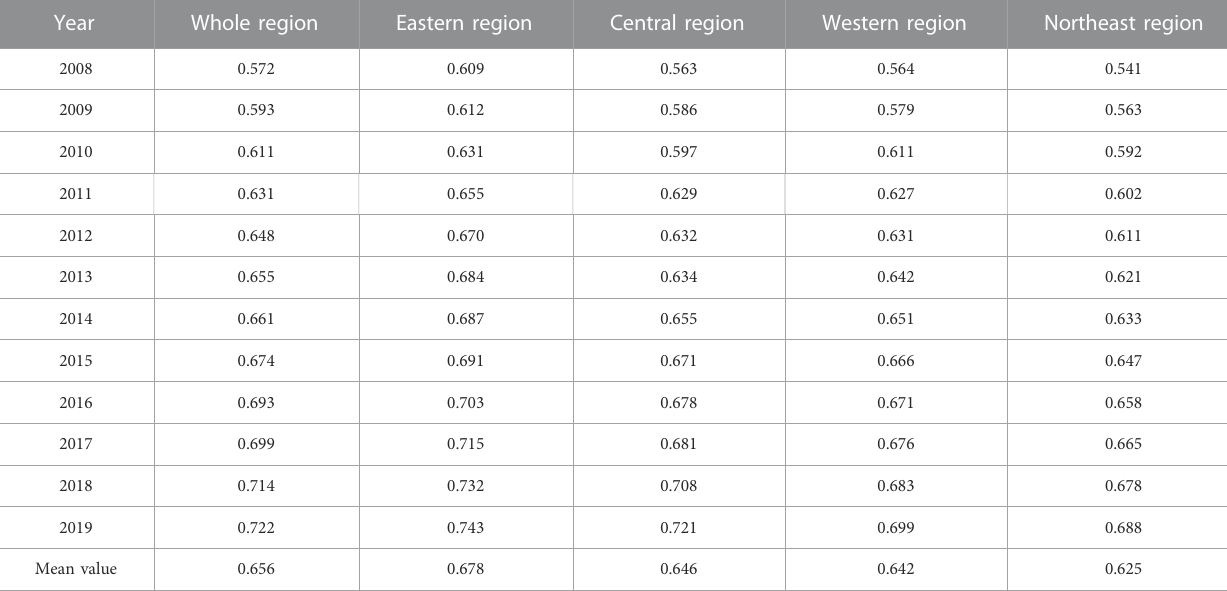
TABLE 5 Change trends of annual average of ATL in different